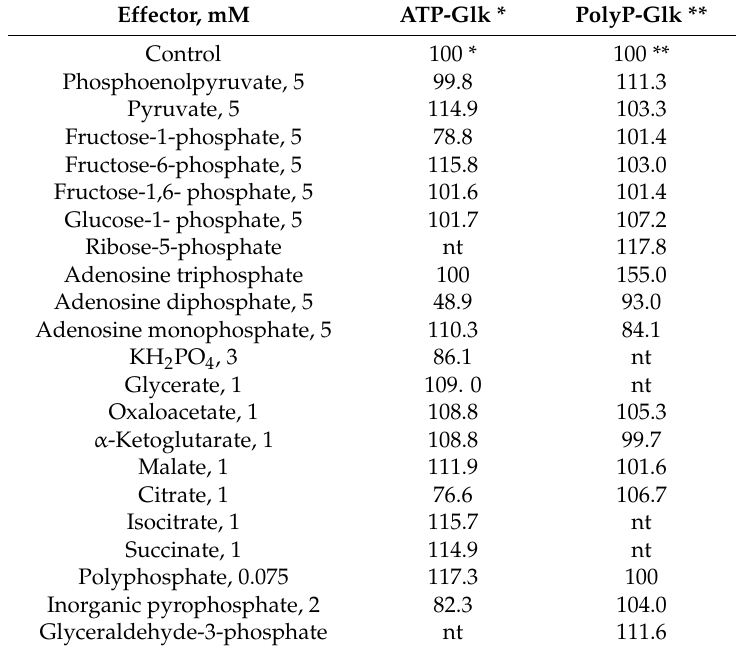
Table 1. Effect of different metabolites on the activities of ATP- and polyP-dependent glucokinases from Methylomonas sp.